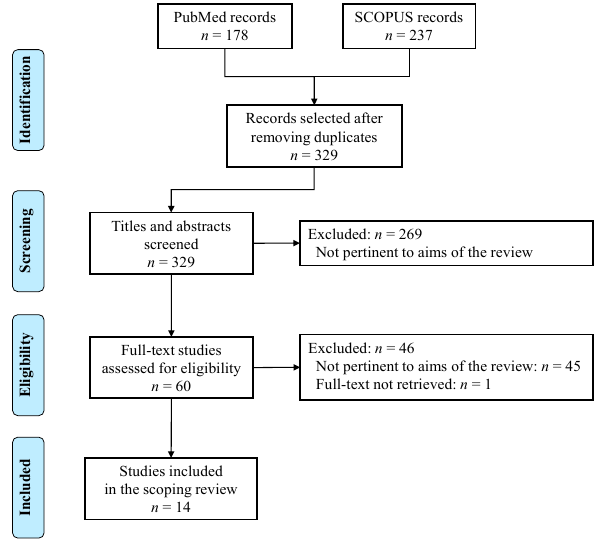
Figure 1. Flow diagram of the studies selection process.